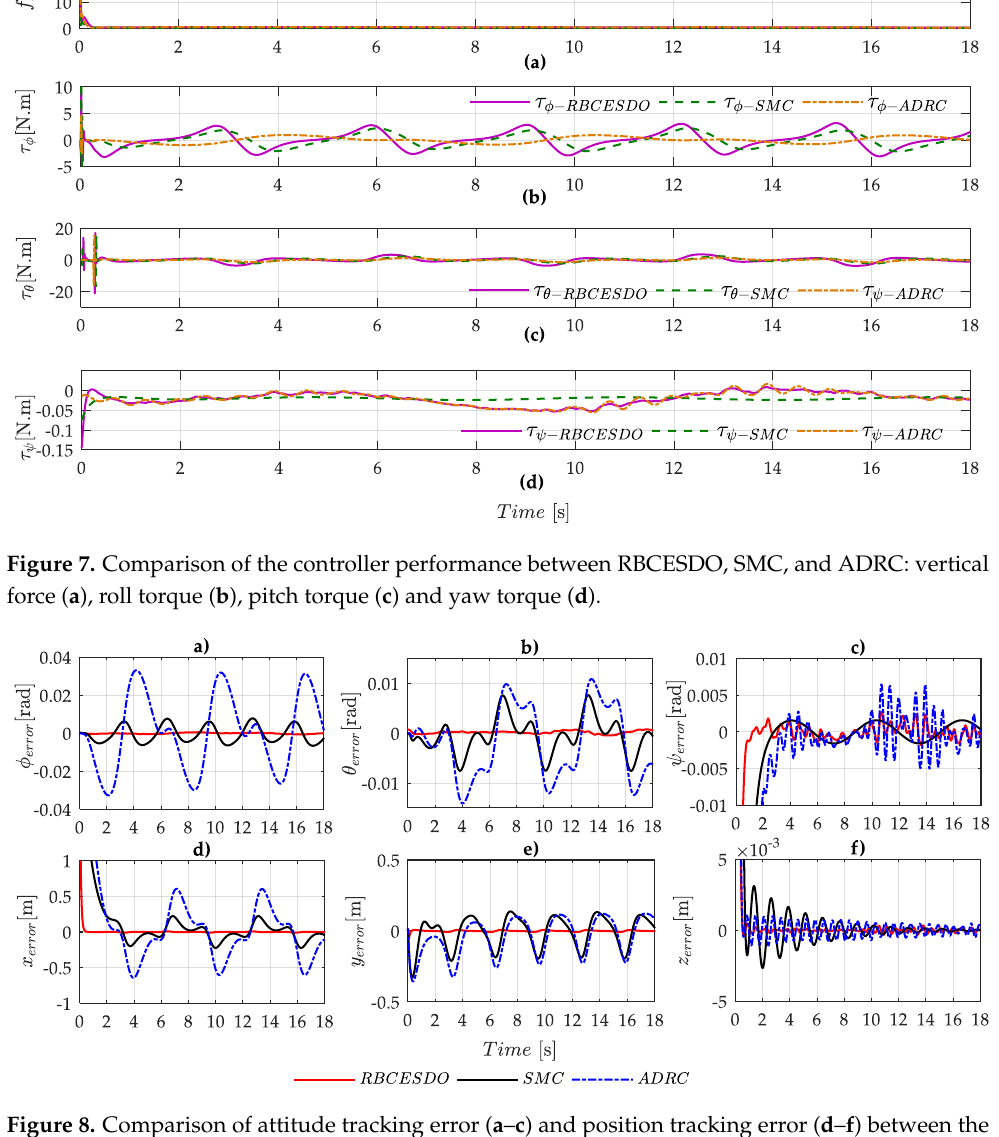
Figure 8. Comparison of attitude tracking error ( a – c ) and position tracking error ( d – f ) between the proposed RBCESDO, SMC, and ADRC.